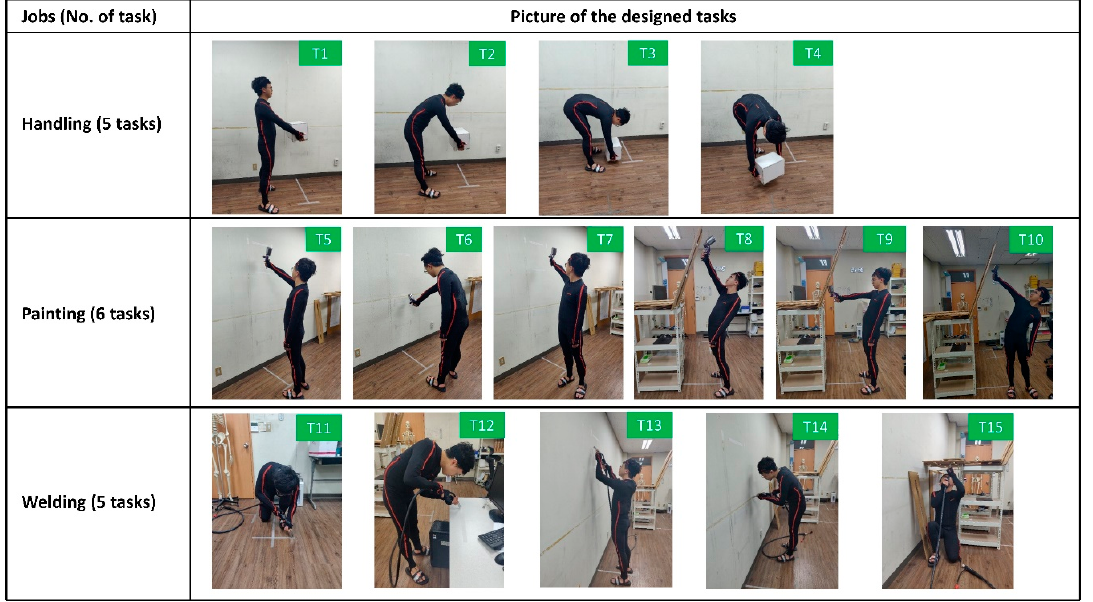
Figure 6. Designed tasks for validating the proposed system.